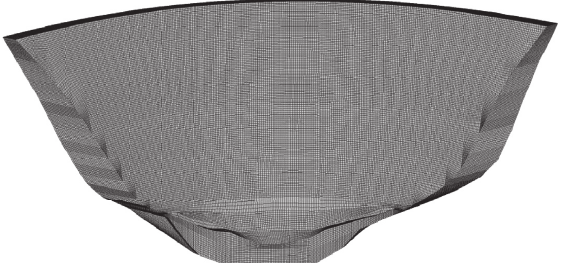
Figure 11: The dam model.